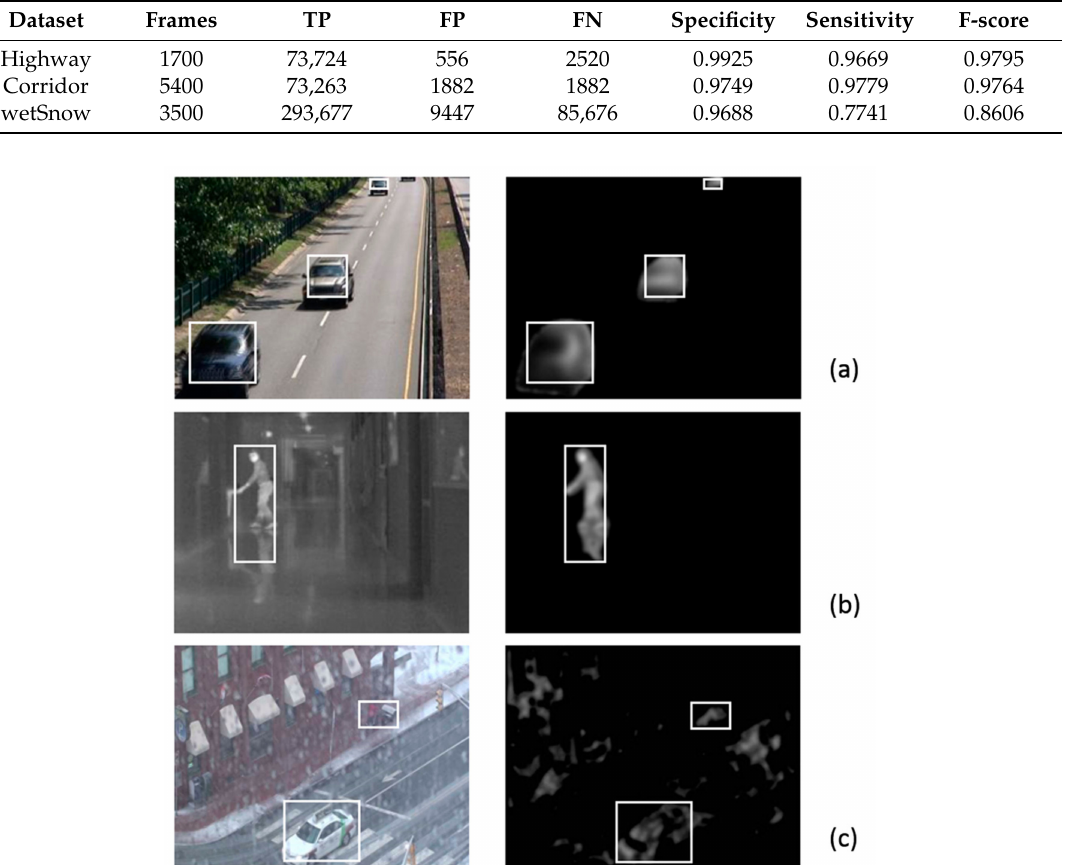
Figure 6. Results of applying the ALI method to three datasets from the ChangeDetection.NET (CDNET) website. ( a ) Highway. ( b ) Corridor. ( c )